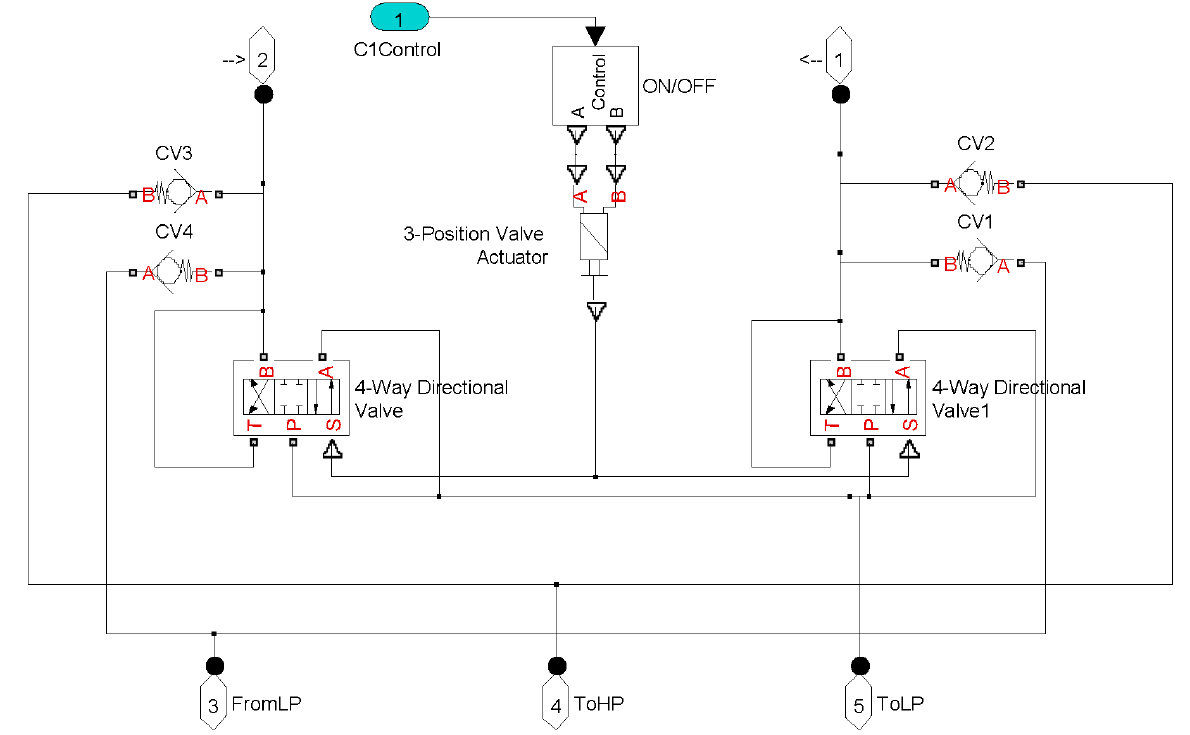
Figure 6. Valves block